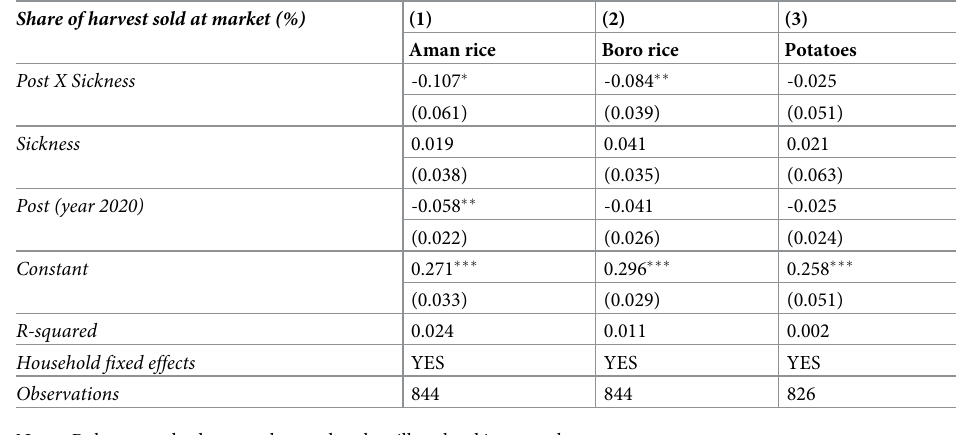
Table 6. Regression results for COVID-19 effects on market sales outcomes.